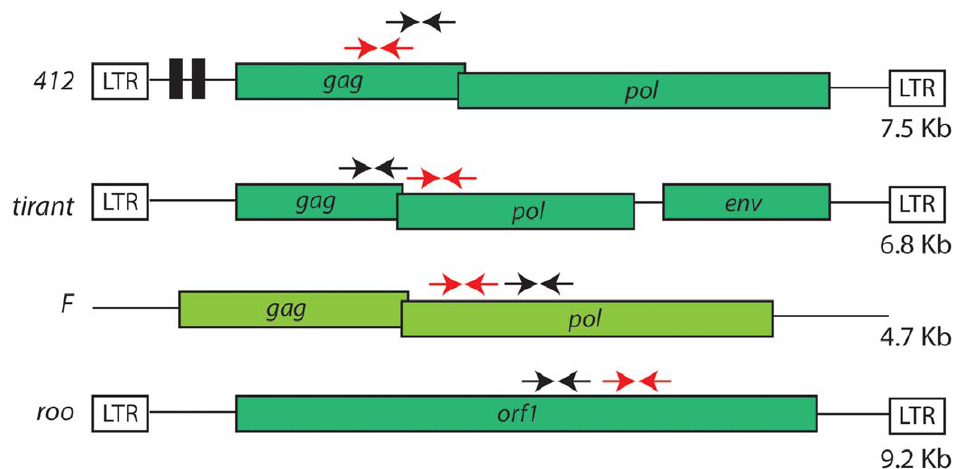
Figure 1. Cartoon of the four retrotransposons studied (not to scale). Colored boxes represent open reading frames (ORF) and white boxes long terminal repeats (LTR). Arrows represent the quantitative PCR primers used for ChIP-qPCR (black arrows) and expression analysis (red arrows). The size of each canonical element is given.